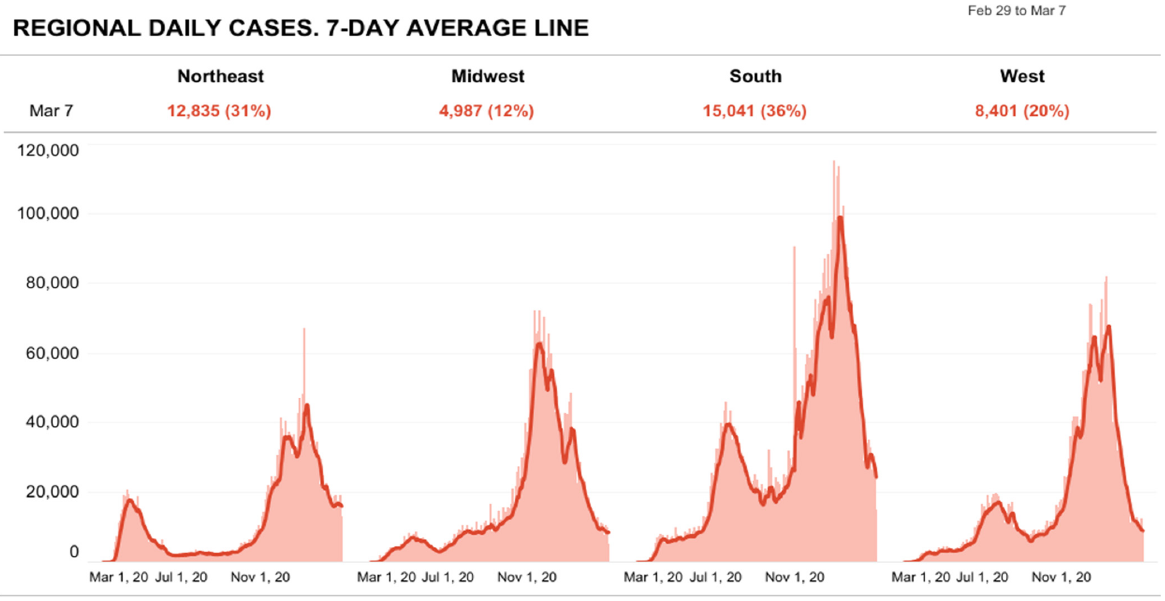
Figure 3. Counties Classed as U.S. Regions: Regional daily cases as 7-day average line” (Source: Reproduced from The COVID Tracking Project) [25].